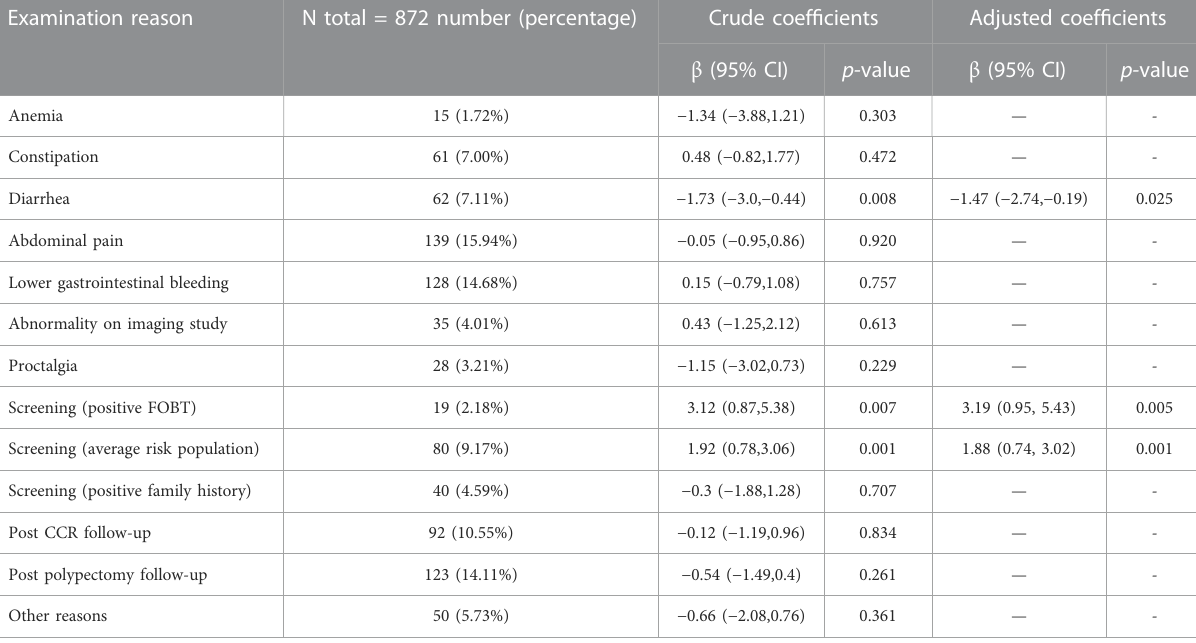
TABLE 7 Crude and adjusted linear regression models for ADR